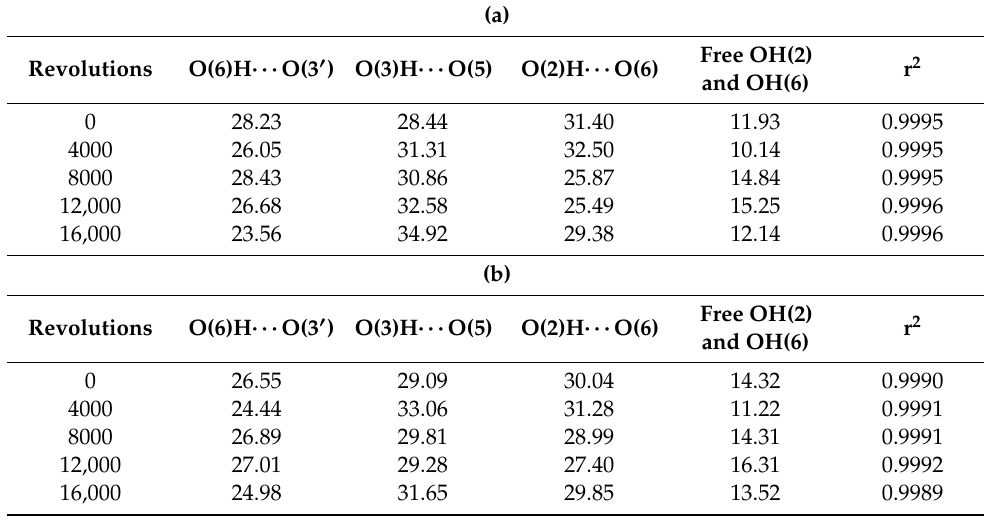
Table 2. ( a ) The relative content of three H-bonds and the free OH for softwood fibers through refining. ( b ) The relative content of three H-bonds and the free OH for hardwood fibers through refining.